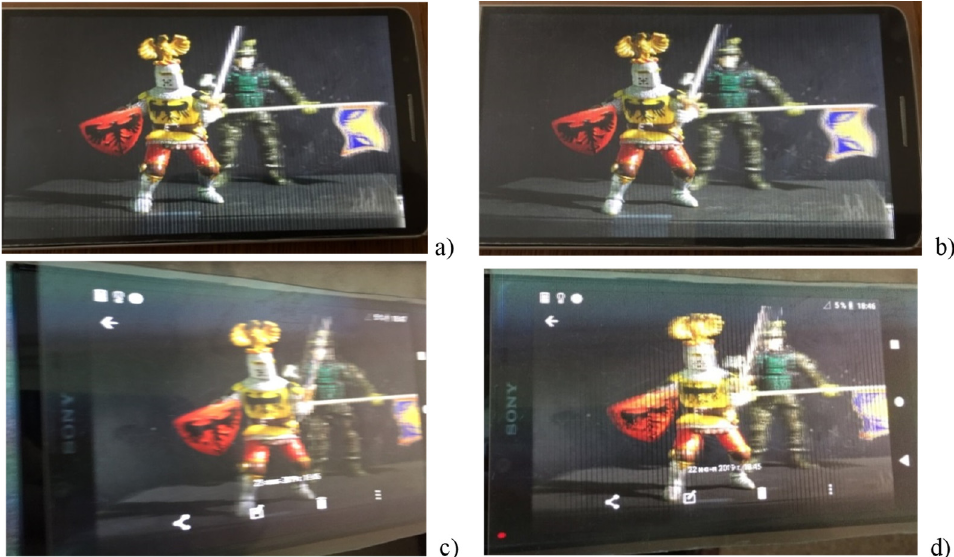
Figure 15. Three-dimensional images on the LG G3 ( a , b ) and 4K Sony ( c , d ) mobile phones from different viewing directions. different viewing